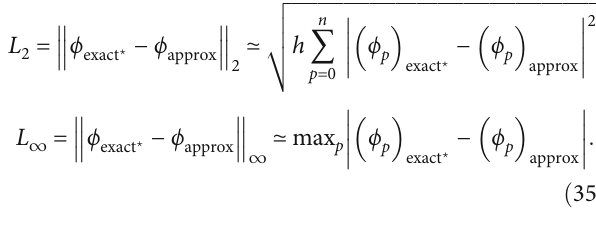
tional work, the values of the parameter α = 0 : 95 , step length h = 0 : 01 , and Δ t = 0 : 00943 are chosen, and for t = 0 : 25 to t = 5 computation, it was carried out over di ff erent fi nite